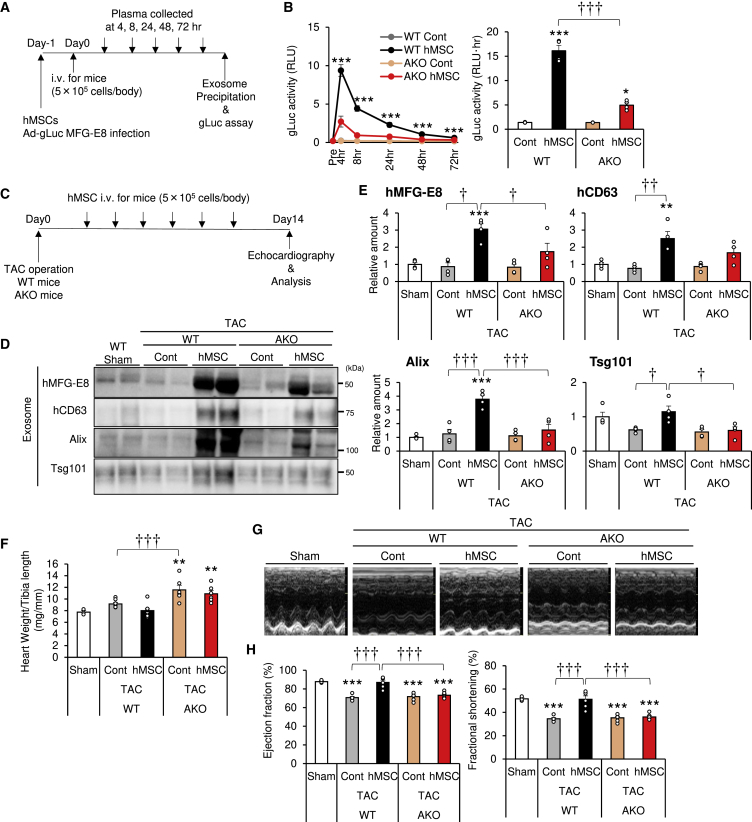
Importance of Circulating Adiponectin for the Cardioprotective Effects of hMSCs(A) Experimental design for adenovirus Gaussia luciferase (Ad-gLuc)-MFG-E8-infected hMSCs. Infected hMSCs were injected i.v. at 5.0 × 105 cells per body into adiponectin knockout (AKO) and wild-type (WT) mice via the tail vein. Blood was collected at 4, 8, 24, 48, and 72 h. Plasma exosomes were precipitated by Exo Quick and ultracentrifugation, as described in Materials and Methods. (B) gLuc activity of plasma exosome was analyzed using a luminometer. The area under the curve (AUC) was calculated (n = 3–4). (C–H) hMSCs were injected i.v. at a concentration of 5.0 × 105 cells per body via the tail vein in the transverse aortic constriction (TAC) model in AKO and WT mice. (C) Experimental design for hMSC delivery into the TAC model. The injection was repeated six times at 2- to 3-day intervals within a period of 2 weeks. Echocardiography was performed at day 14. (D) Serum exosomes were subjected to western blot analysis with the indicated antibodies of exosome markers. (E) Exosome marker levels from western blots (n = 3–4). (F) Heart weight per tibia length ratio (n = 3–10). (G) Representative images of echocardiography. (H) Ejection fraction (EF) and fractional shortening (FS) estimated at 2 weeks after TAC or sham surgery (n = 3–6). Data are mean ± SEM. The experiments were tested in two separate trials. ∗p < 0.05; ∗∗p < 0.01; ∗∗∗p < 0.001 versus sham. †p < 0.05; ††p < 0.01; †††p < 0.001 between groups, by one-way analysis of variance with post hoc Tukey’s multiple comparisons.